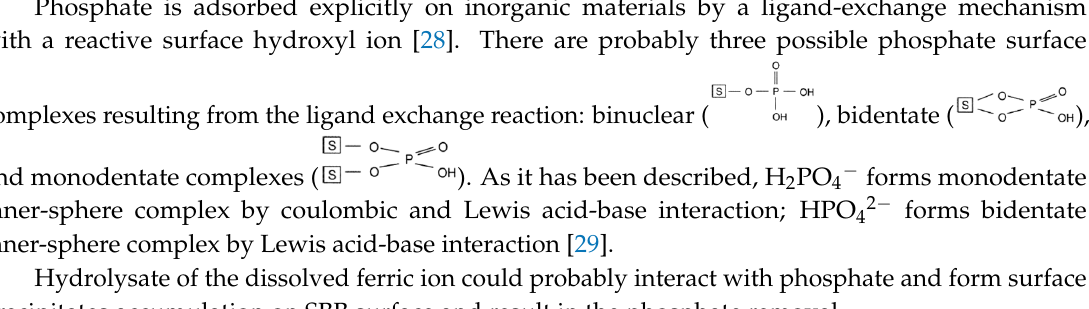
Note: The Fe(II) and Fe(III) satellite peaks and the single surface structure peak are not shown, so the total peak area of each sample in this table is not equal to 100.